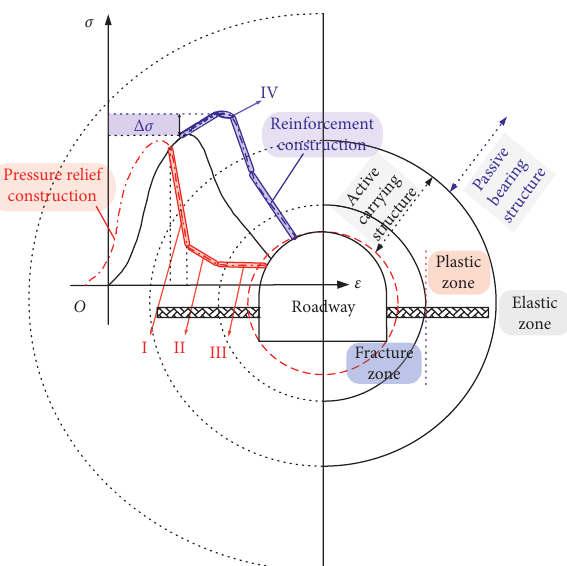
Figure 11: Mechanical characteristic model of surrounding rocks.